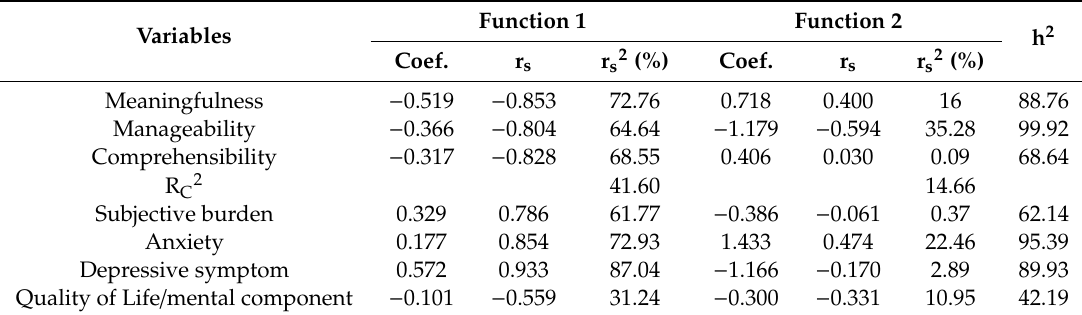
Table 2. Canonicalresultsforsenseofcoherence(SOC)dimensionsandpositiveandnegativeconsequences for each function.